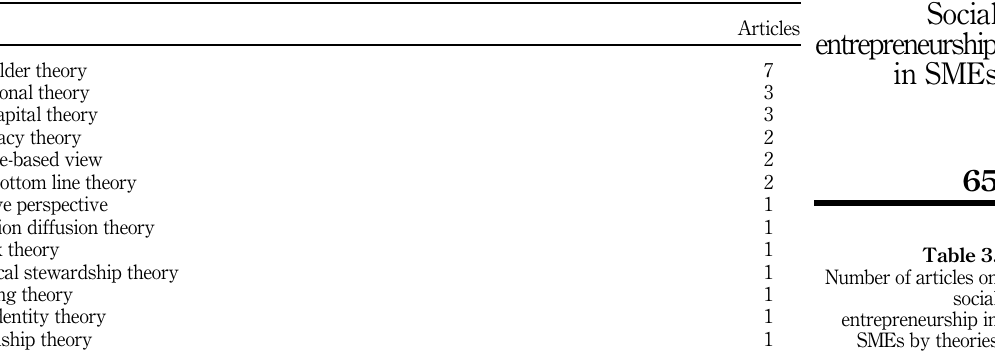
Table 3. Number of articles